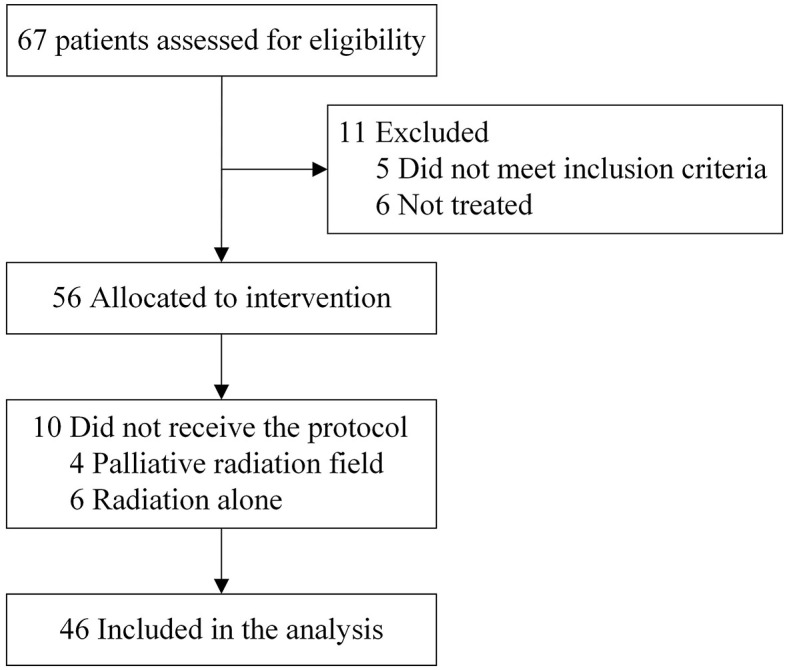
CONSORT diagram.